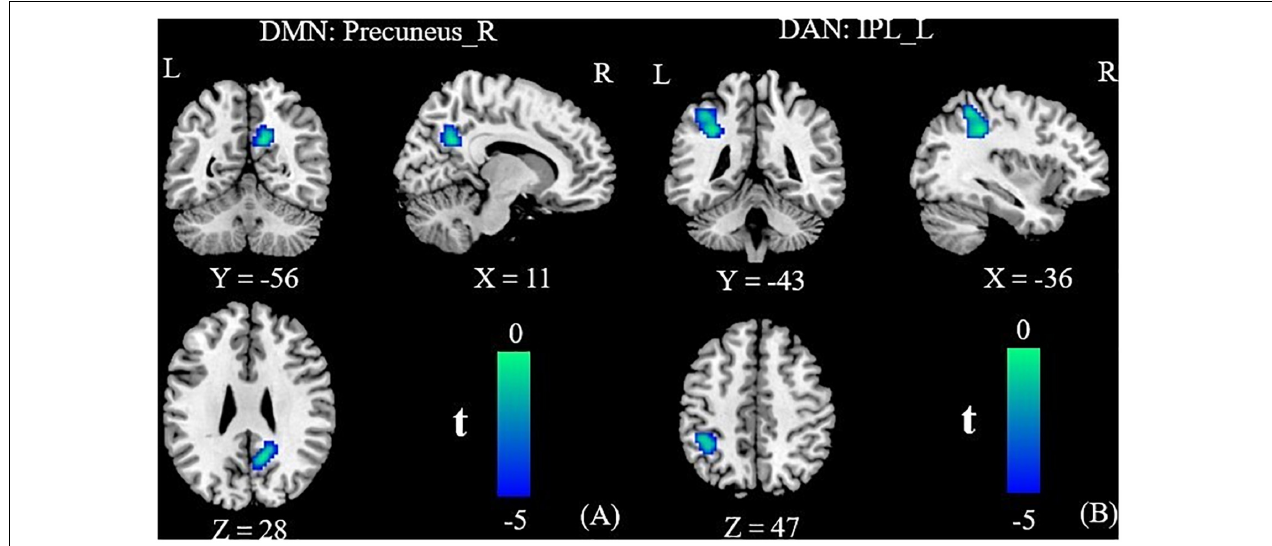
FIGURE 2 | Group functional connectivity (FC) differences within RSNs. Significant differences between the T2DM and HC groups were found within the DMN (A) and the DAN (B) . DMN, default mode network; DAN, dorsal attention network; IPL, inferior parietal lobule; R, right; L, left.